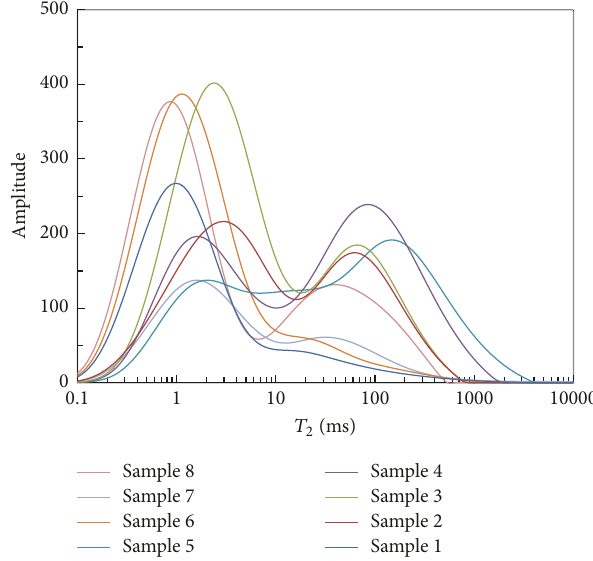
Figure 1: 𝑇 2 distribution map of the 8 samples.